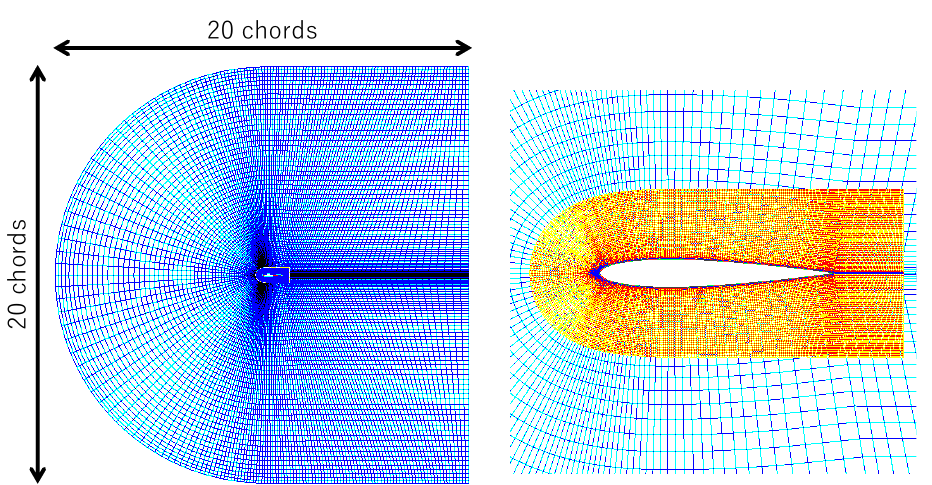
Figure 1. Computational grid for NACA0012. The left and right figures depict overall and enlarged views around the airfoil, respectively. The black and blue lines indicate the main and sub grids,